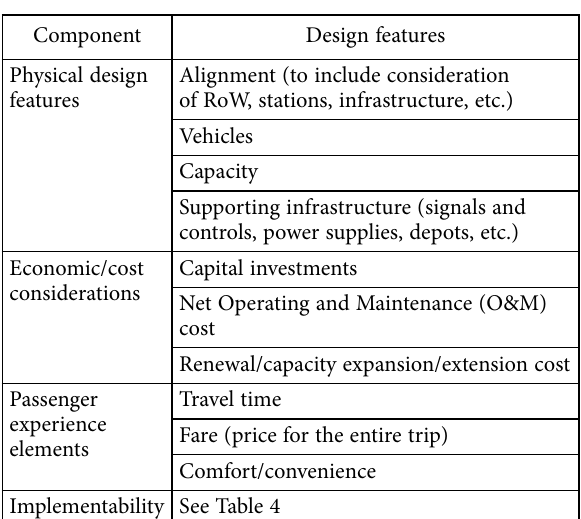
Table 3. The principal components and design